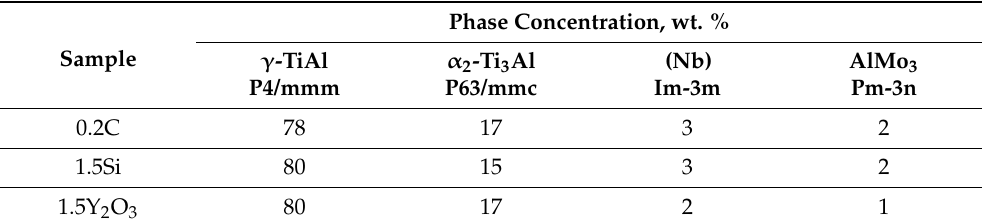
Table 1. The phase composition of the HIP-ed alloys 0.2C, 1.5Si, and 1.5Y 2 O 3